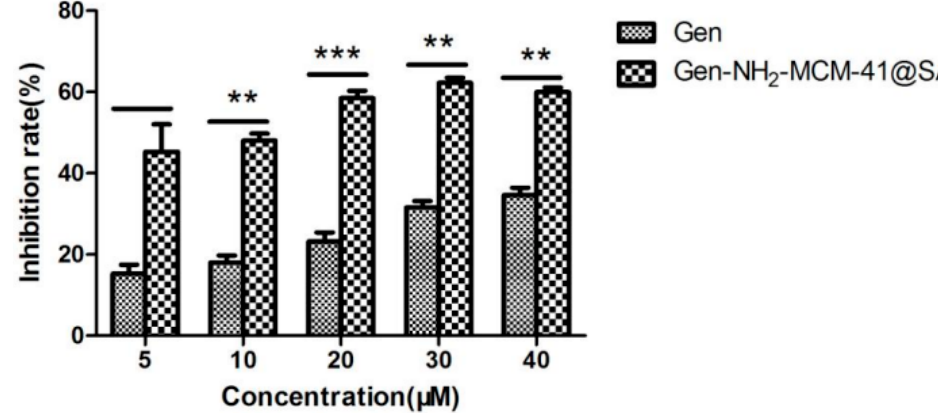
Figure 16. Anti-RV biosynthesis activity of Gen-NH 2 -MCM-41@SA and Gen (** p < 0.01, *** p < 0.001).